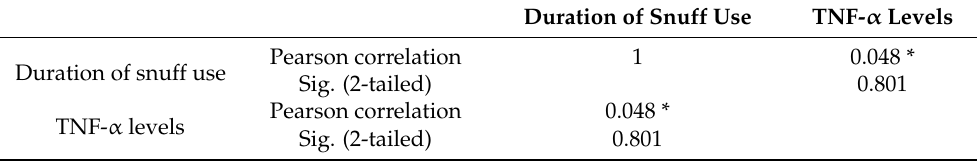
Table 5. Correlation between duration of snuff use and TNF- α